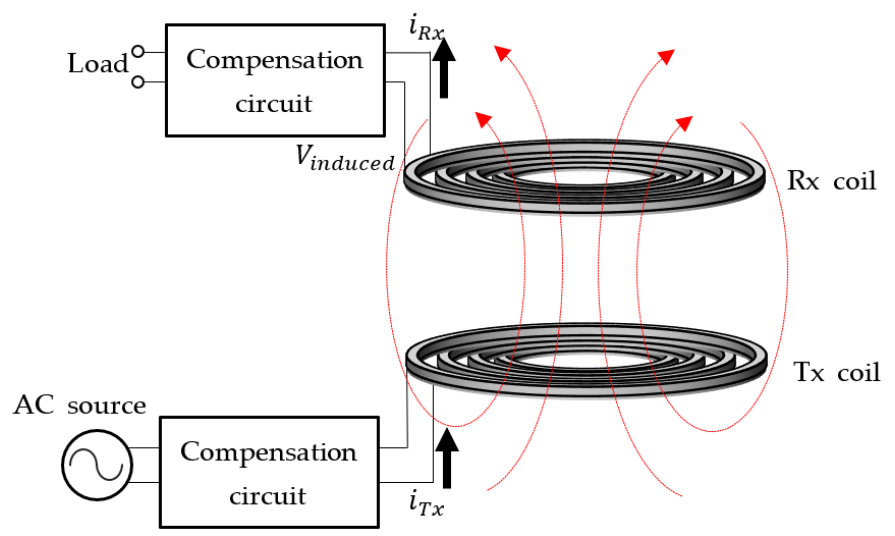
Figure 1. Principle of the inductive power transfer method.